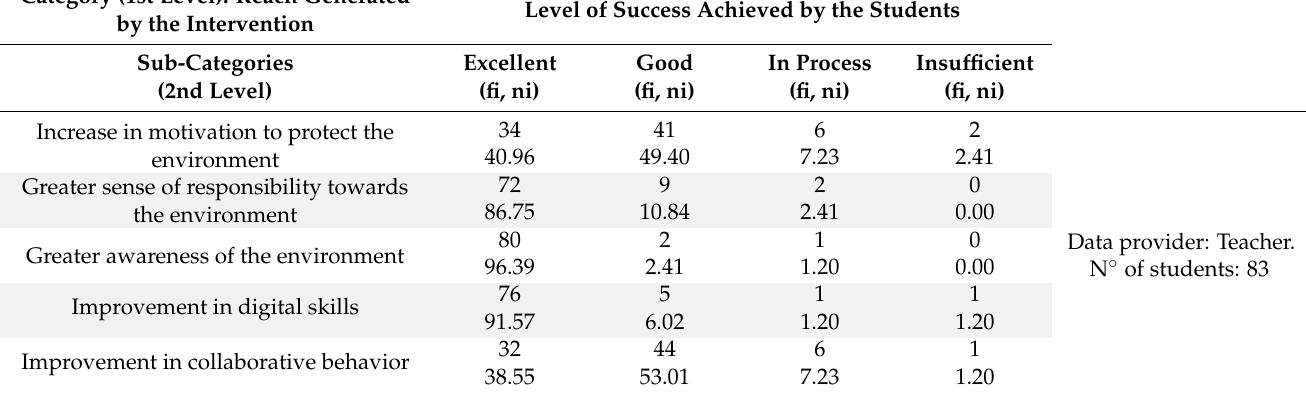
Table 5. Impact of the intervention on the